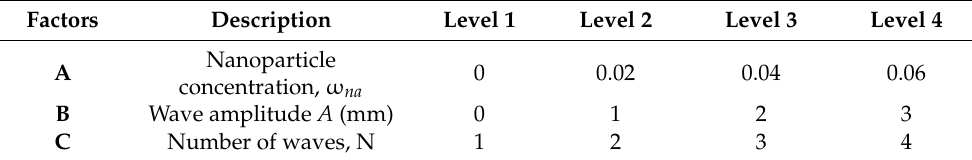
Table 3. The range and levels of control parameters.